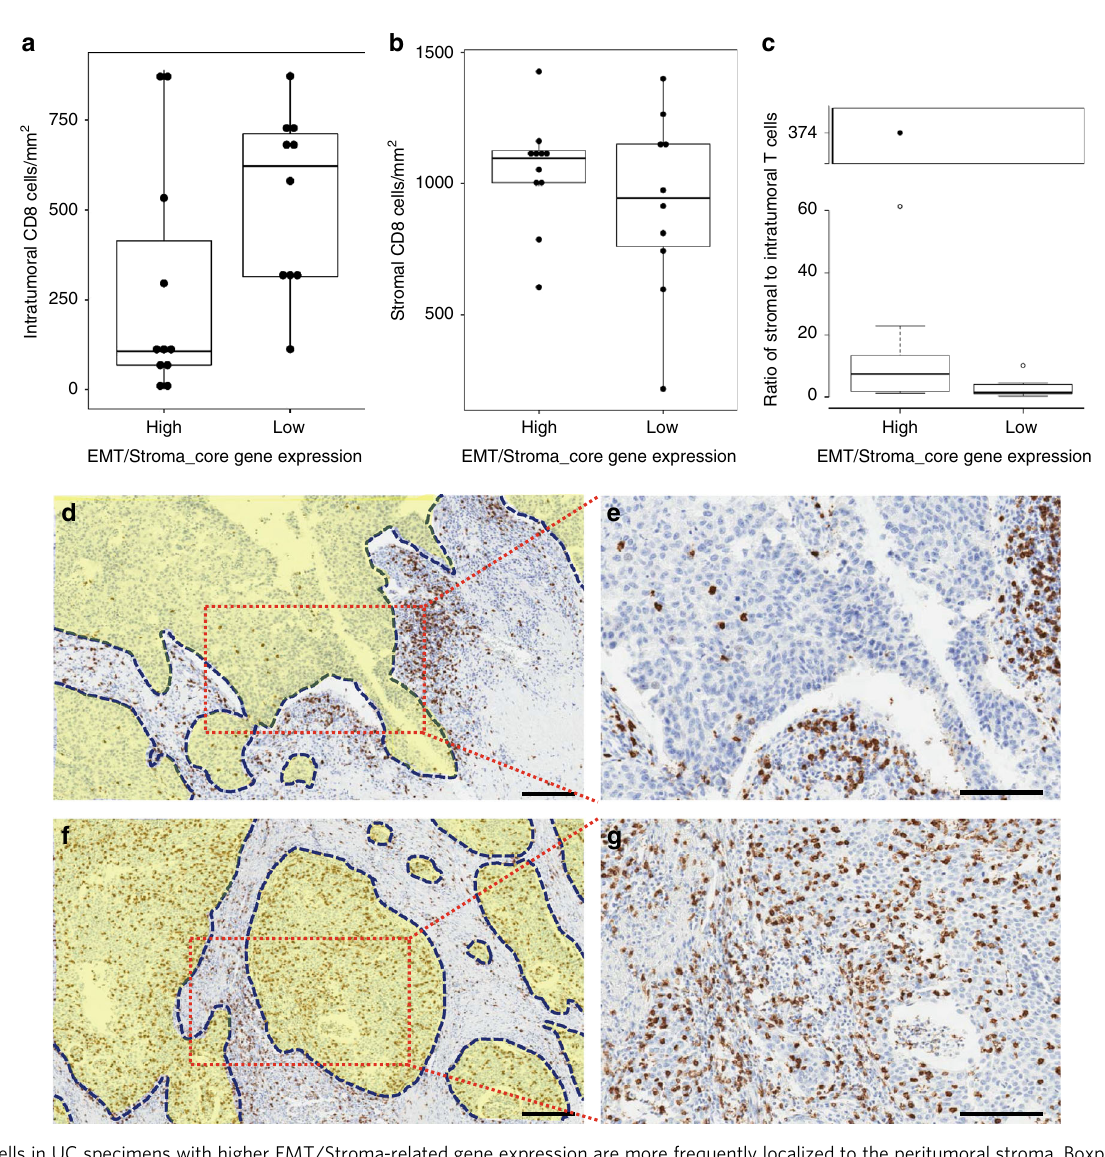
Fig. 7 T-cells in UC specimens with higher EMT/Stroma-related gene expression are more frequently localized to the peritumoral stroma. Boxplots of the density of a intratumoral or b peritumoral-stroma CD8 cells in specimens ( n = 21), by EMT/Stroma_core gene expression category ( ≥ or < median level); c Ratio of peritumoral stroma CD8 cells to intratumoral CD8 cells; d , e Representative tumor specimen with low intratumoral CD8 cells and high peritumoral stromal CD8 in fi ltrates, and f , g with high total and intratumoral CD8 cells. Yellow-shaded zones in images d and f identify tumor areas, whereas the rest represent adjacent stroma. Scale bars correspond to 200 μ m. In boxplots, boxes extend from the fi rst to third quartiles, middle line shows median, whiskers extend up to 1.5 times the interquartile range from the top and bottom of the box to the furthest data within that distance. Data beyond the end of the whiskers are “ outlying ” points. In a and b , fi lled circles show individual values. In c , the outlying point with extreme value is boxed with a break in the Y axis to better display the entire distribution of the data. Two lines at the end of the whiskers correspond to the maximum and minimum of the data points with the extreme outlier